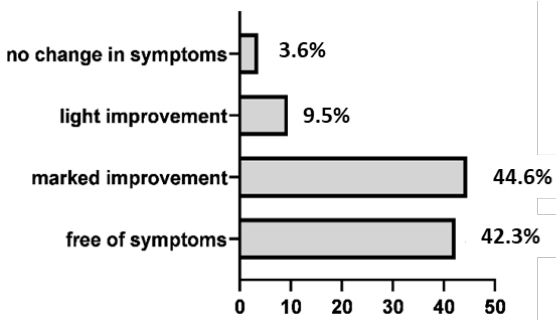
Figure 3. Overview of subjective evaluation of clinical results (in %).